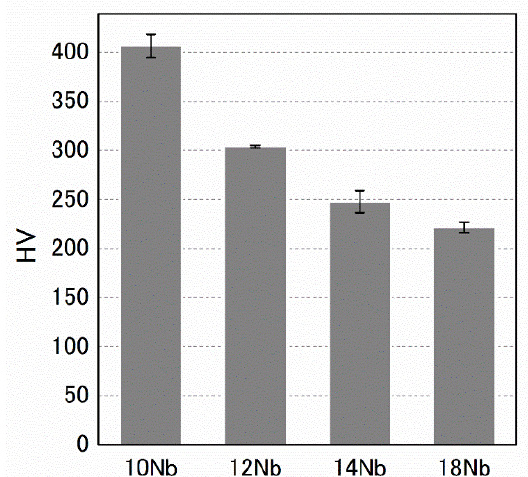
Figure 4. HV variation of the Zr-x at.% Nb alloys.